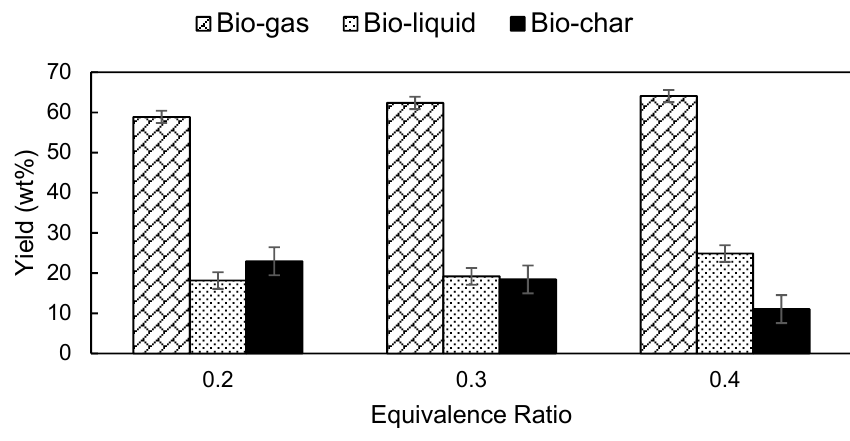
Figure 3. Effect of ER on the NG gasification product yield.